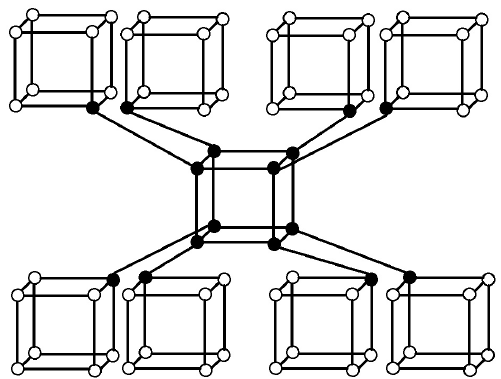
Figure 2. Crystal Structure Cubic Carbon CCC ( 2 )